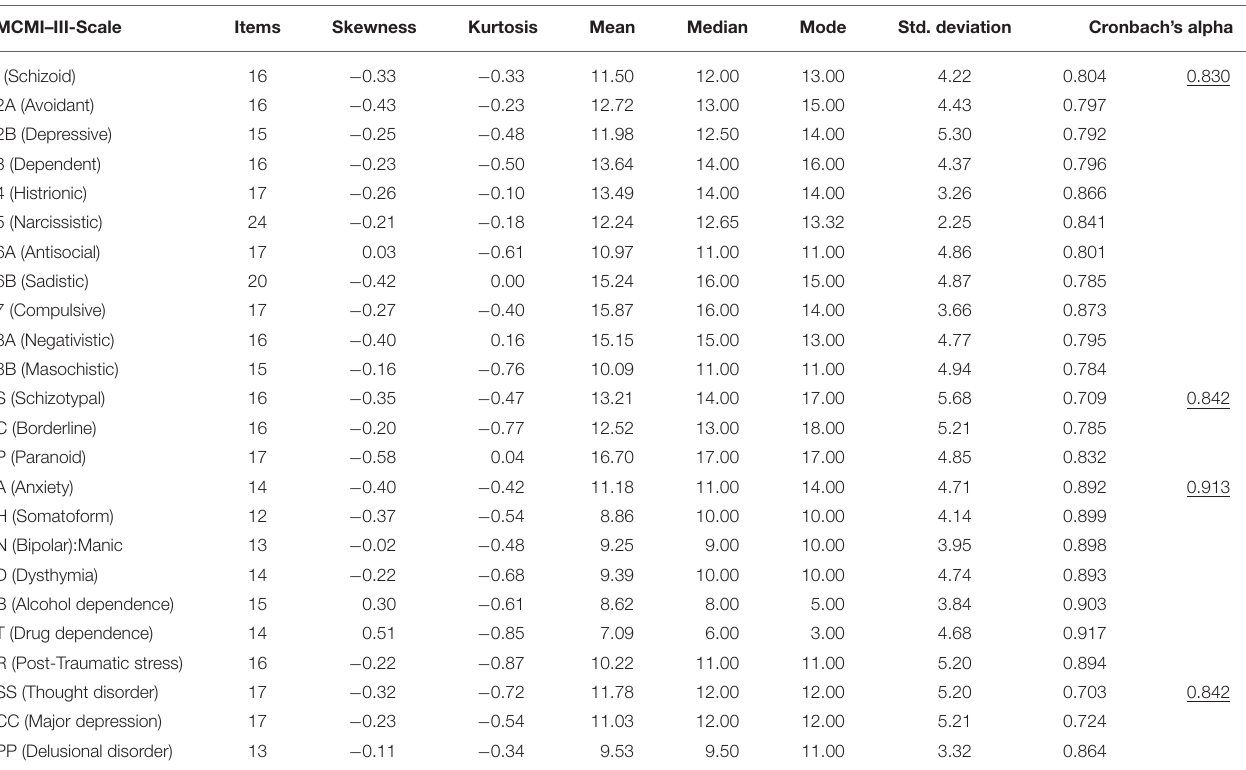
TABLE 2 | Skewness and kurtosis, mean, median, and mode, standard deviation, and reliability of scales of MCMI–III. MCMI–III-Scale Items Skewness Kurtosis Mean Median Mode Std. deviation Cronbach’s